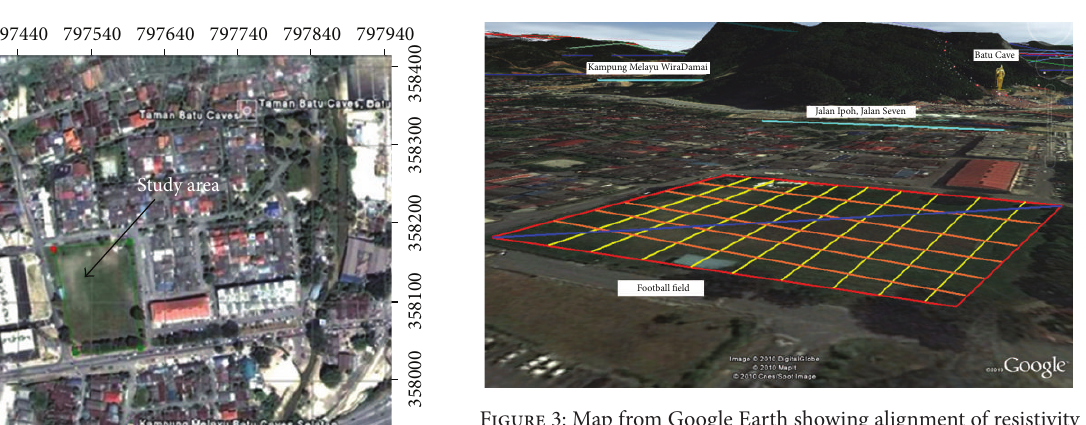
diagonally (Figure 3). The length of each line is 80 m with the exception of the diagonal line, which is 160 m.